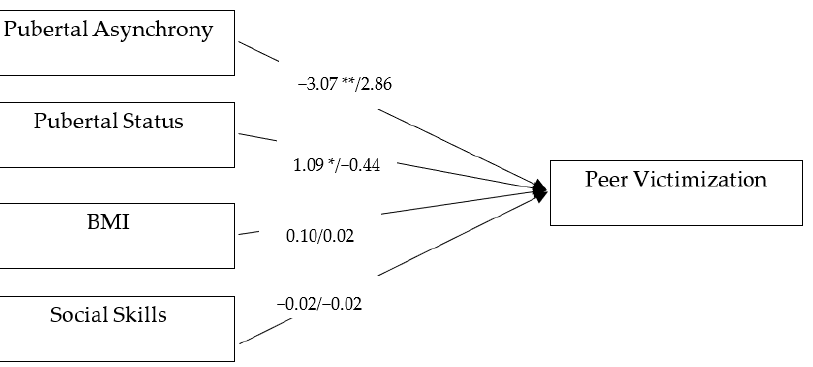
Figure 1. The effects of pubertal asynchrony and pubertal status on adolescents’ peer victimization at age 11. Note. * p ≤ 0.05. ** p ≤ 0.01. Girls are in the right side of the slash. Covariates including race/ethnicity, parental marital status, and income were included in the model but not shown here for simplicity. Figure reports unstandardized coefficients. Fit indices: χ 2 ( 2 ) = 0.61, p = 0.73, CFI = 1.00, TLI = 1.00 RMSEA = 0.00, 90 % CI for RMSEA = [0.00, 0.13].